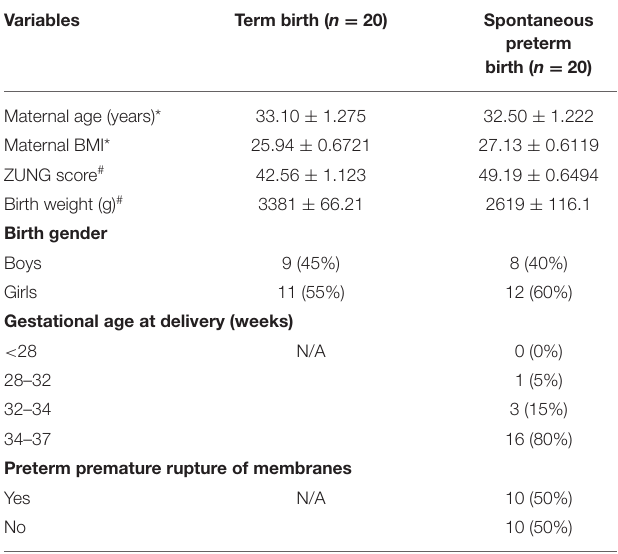
TABLE 1 | Medians or Counts (%) for demographic and clinical variables.